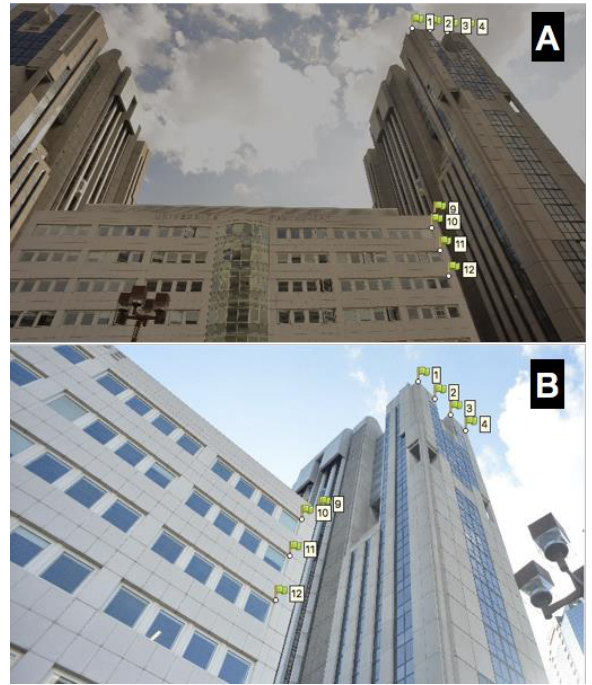
Figure 5. Points’ Position on images World coordinate of markers were obtained from the georeferenced 3D model (Table 2).